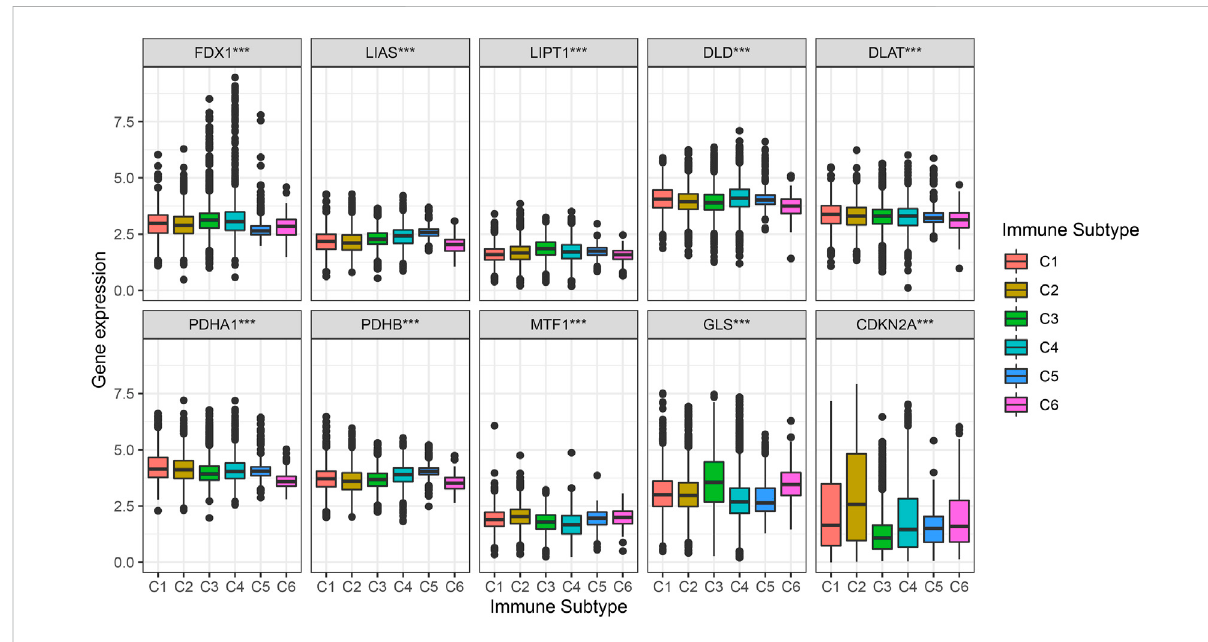
FIGURE 6 Correlation analysis between cuproptosis-associated genes and six immune subtypes. C1, wound healing, C2, IFN- γ dominant, C3, in fl ammatory, C4, lymphocyte depleted, C5, immunologically quiet, and C6, TGF- β